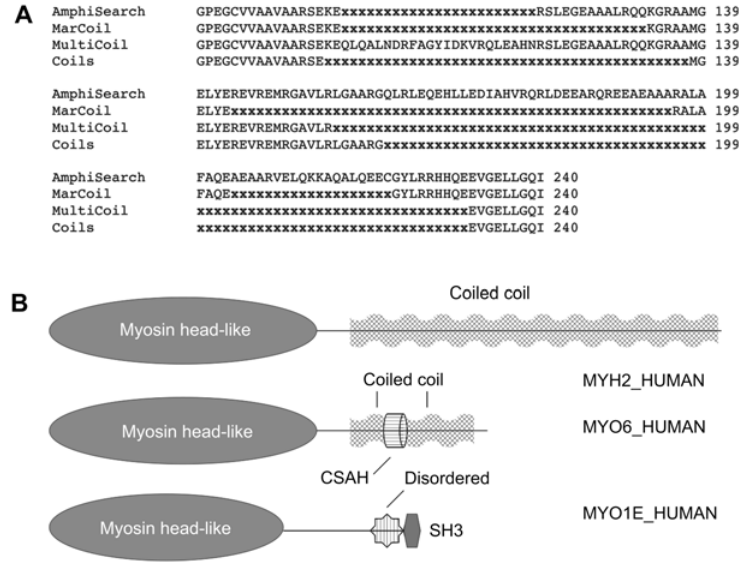
Figure 5 Variations for coiled coil recognition and occurrence in proteins. (A) Results of coiled coil predictions with different algorithms on the same sequence. A segment of the mouse neurofilament heavy peptide (SwissProt ID: NFH_MOUSE) is shown as an example, residues predicted from coiled coils are masked by ‘ x ’. Prediction results are taken from Ref. (56). (B) Domain composition of three human myosins. Assignments are based on SwissProt annotations plus CSAH detection (93) as well as IUPred (106). Note that analogous position of segments does not necessarily imply